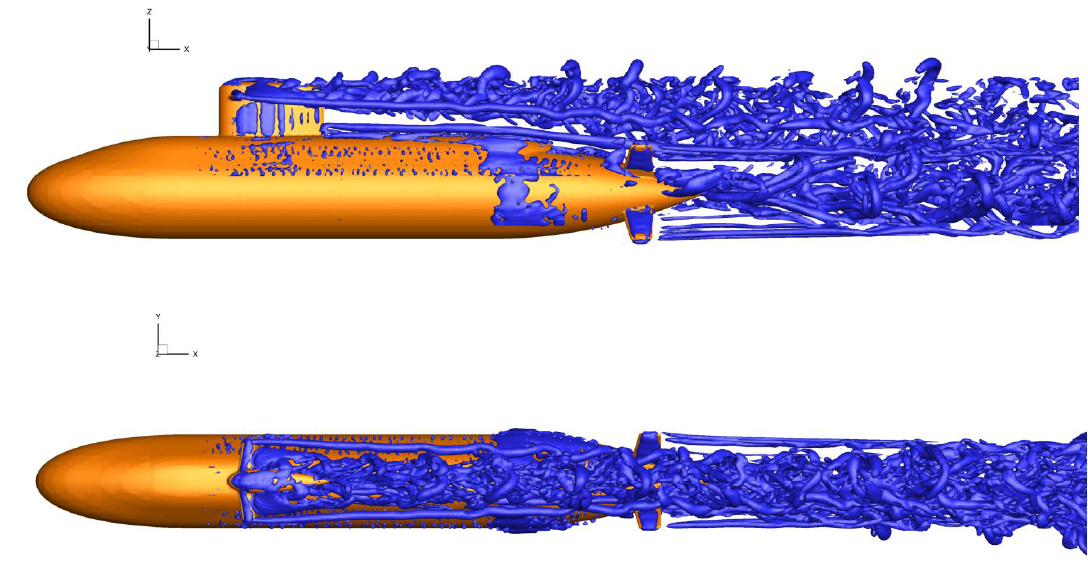
Figure 10. Instantaneous vortex structures visualized by the Q criterion (Q = −